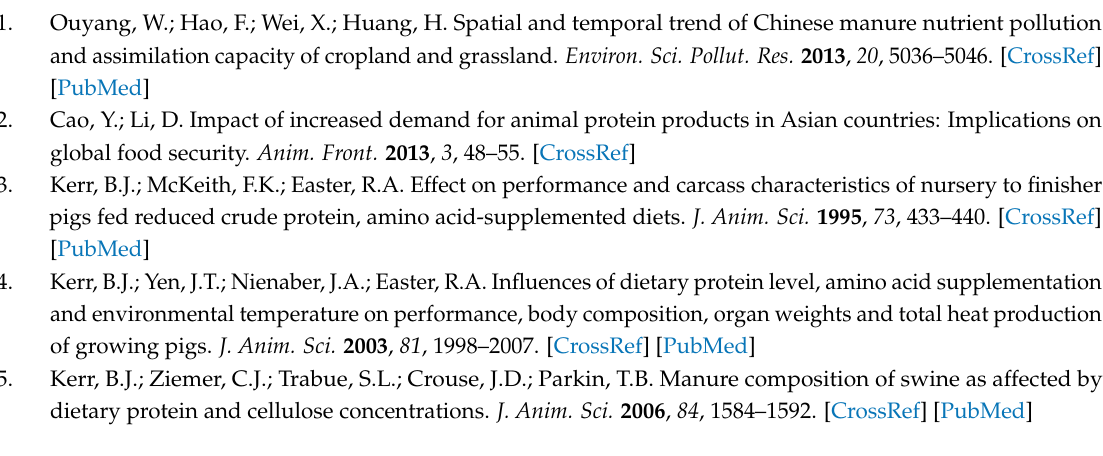
s1, Table S1: Absolute quantitative real-time PCR primers for detecting microbial populations in faeces of finishing